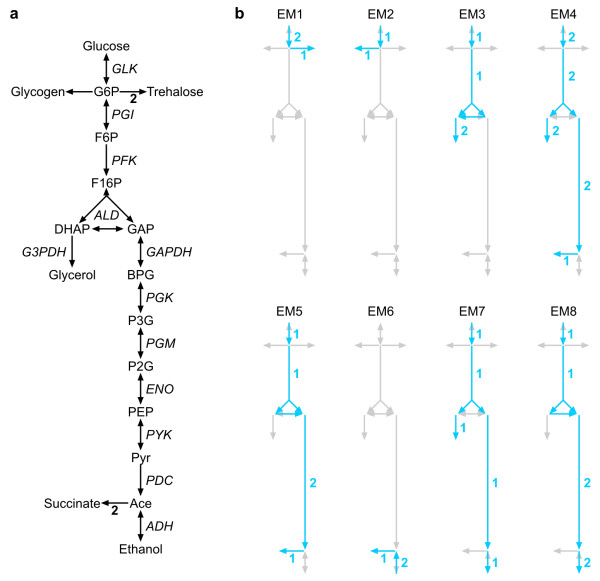
Model of yeast glycolysis. a. Model of yeast glycolysis introduced by [30]. Names in italic are enzymes whose kinetic properties were included in this analysis. Numbers indicate stoichiometries of reactions when different from one. b. The eight elementary modes of the yeast glycolysis system. All elementary modes are irreversible. External metabolites are: glucose, glycogen, trehalose, glycerol, succinate, and ethanol.